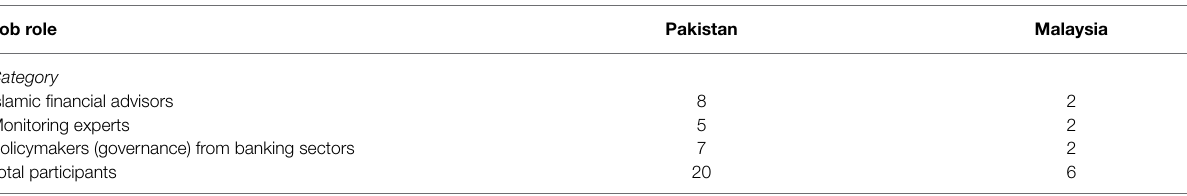
TABLE 2 | Plaintiffs of the